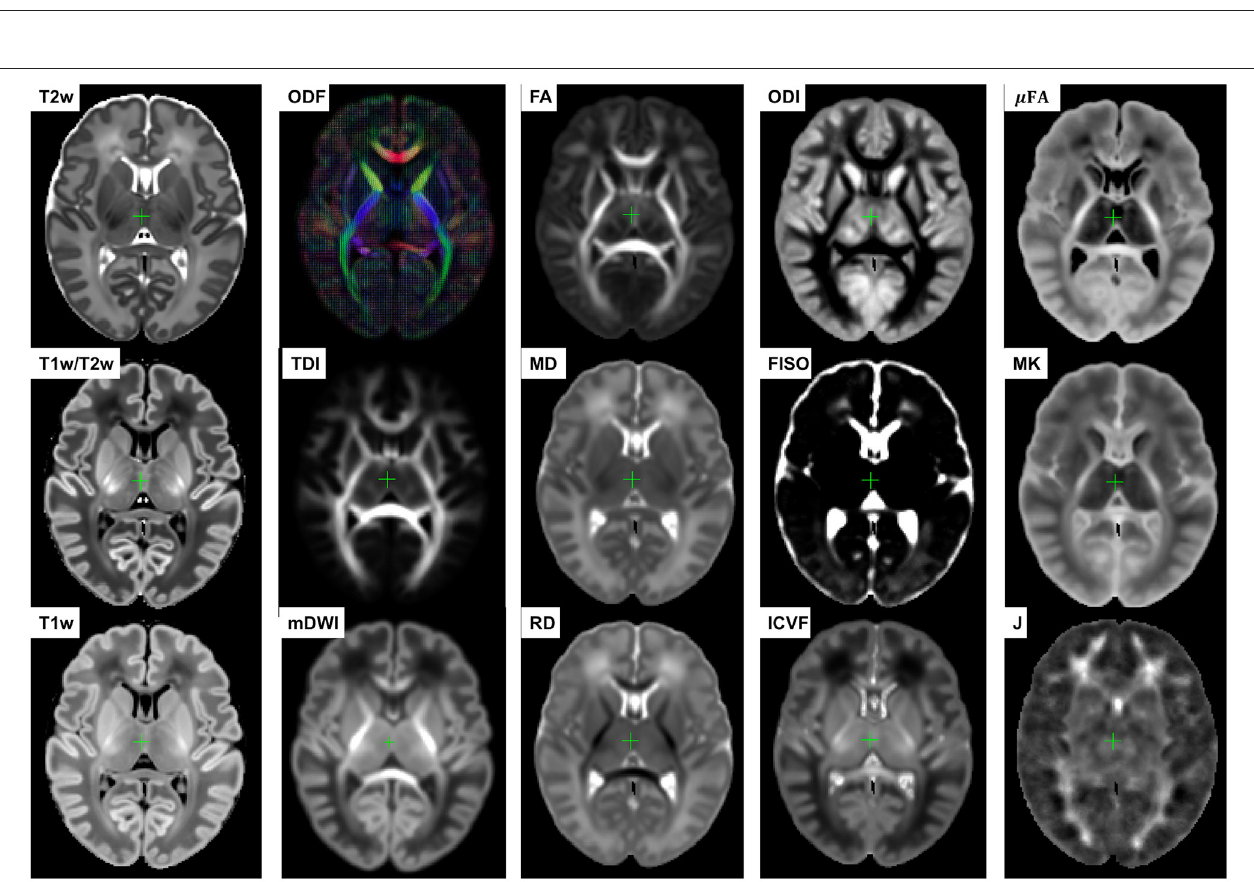
FIGURE 5 | Multi-channel 4D atlas in the reference space (corresponding to 36 weeks PMA). Structural channels: T1, T2, T1/T2 and Jacobian; ODF channels: SH ODF, mDWI, TDI; DTI channels: MD, RD, FA; DKI channel: MK; NODDI channels: ODI, FISO, ICVF; µ FA.